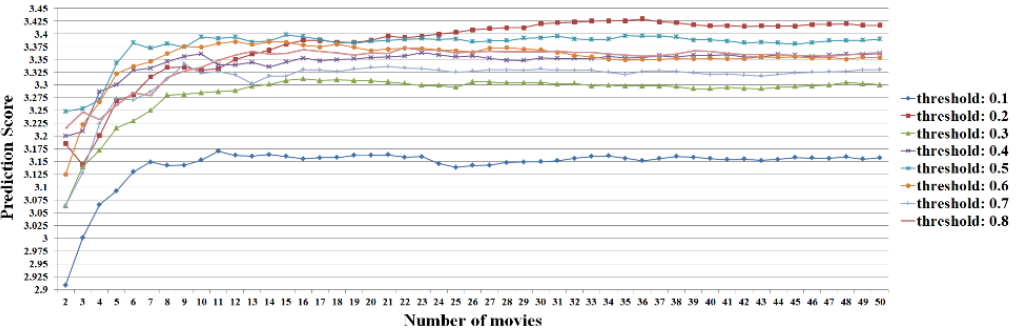
Figure 12. Results of the prediction scores based on the cosine similarity in the item-based filtering.